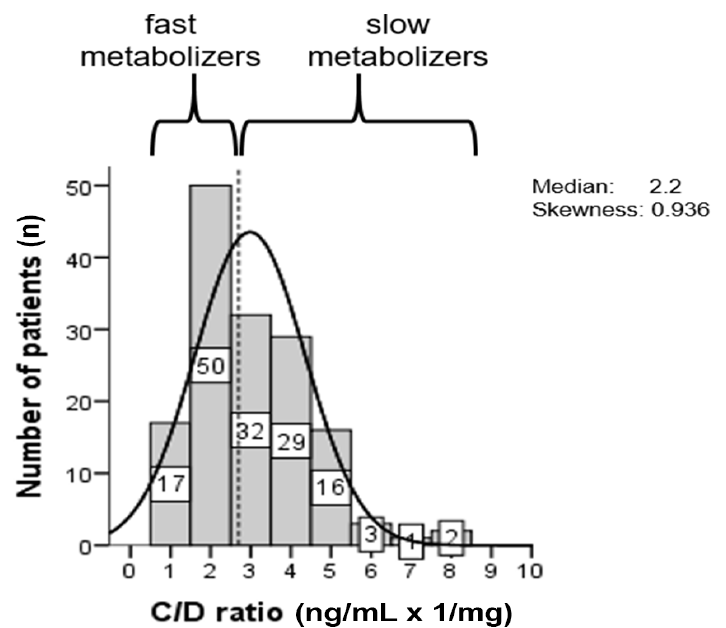
Figure 7. Histogram of the distribution of the tacrolimus C/D ratio (ng/mL × 1/mg). The patients were categorized according to the median value (dashed line) as slow or fast metabolizers [13]. Patients showing a C/D ratio <2.2 were defined as fast metabolizers and patients showing a C/D ratio ≥ 2.2 as slow metabolizers.